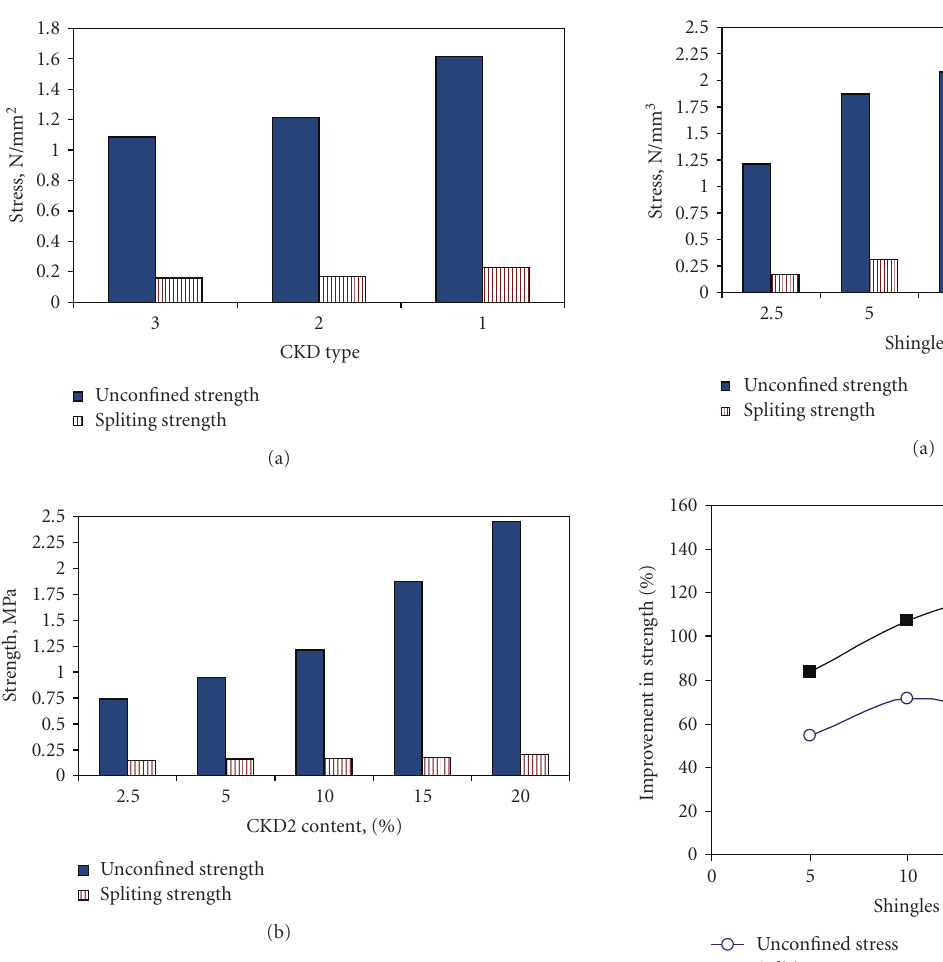
Figure 2: E ff ect of CKD on compressive and split tensile strengths: (a) di ff erent CKD types and (b) CKD2 contents (no shingles). is expected when the number of shingle elements is larger.